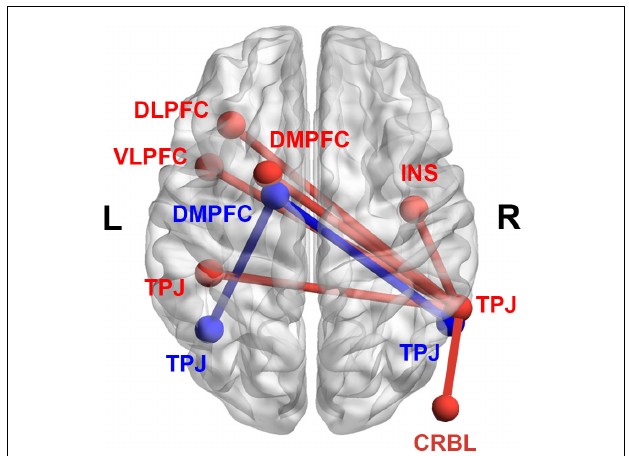
FIGURE 3 | Results derived from the seed-based RSFC analysis. Significant correlations between the RSFC and the IES (an index of dispositional insight). Red color denotes the RSFC seeded from TPJ.R. The RSFC of TPJ.R-TPJ.L, TPJ.R-DLPFC.L, TPJ.R-VLPFC.L, TPJ.R-DMPFC.L, TPJ.R-INS.R, and TPJ.R-CRBL.R were significantly and positively correlated with IES. Blue color denotes the RSFC seeded from DMPFC.L. The RSFC of DMPFC.L-TPJ.R, and DMPFC.L-TPJ.L were significantly and positively correlated with IES. RSFC, resting-state functional connectivity; IES, inverse efficiency score; TPJ.R, right temporoparietal junction; DMPFC.L, left dorsal medial prefrontal cortex; DLPFC.L, left dorsolateral prefrontal cortex; VLPFC.L, left ventrolateral prefrontal cortex; INS.R, right insula; CRBL.R, right cerebellum.